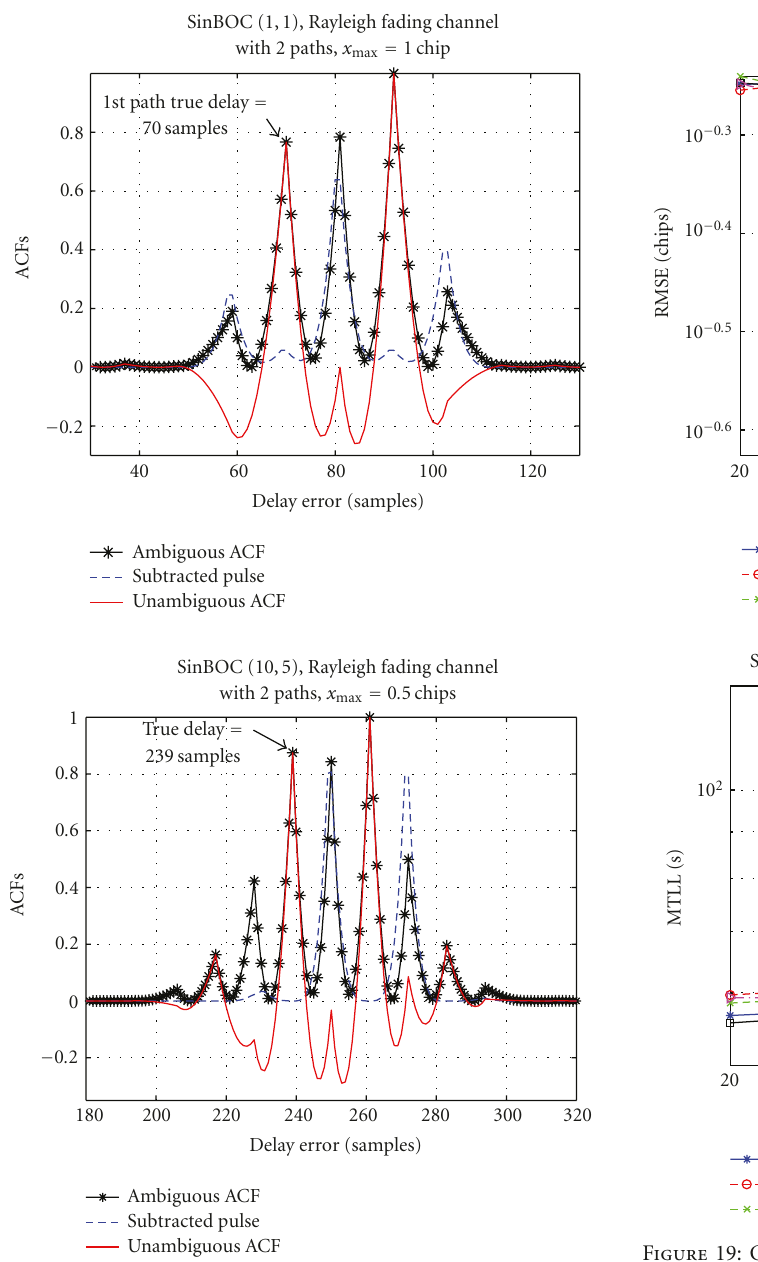
Figure 18: Exemplification of SCM method for a 2-paths Rayleigh fading channel. Upper plot: SinBOC(1,1)-modulated signal and x max = 1 chip. Lower plot: SinBOC(10,5)-modulated signal and x max = 0 . 5 chips.